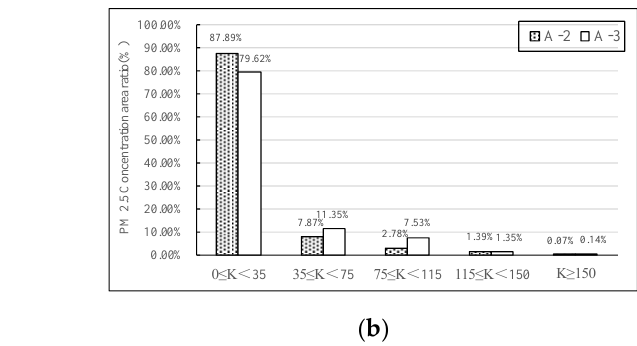
Figure 10. Column Analysis Chart: ( a ) air velocity area ratio of A-2 and A-3 kitchens. ( b ) PM2.5 concentration area ratio of A-2 and A-3 kitchens.